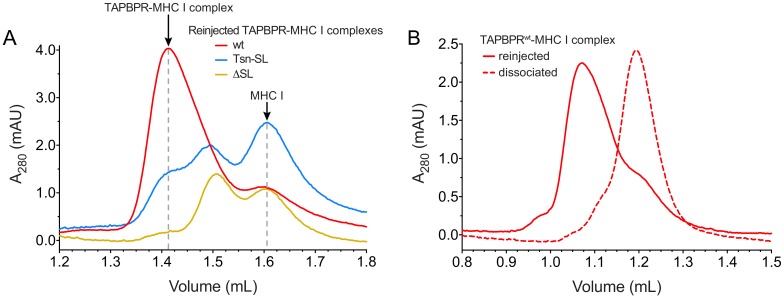
Stability of the MHC I complex formed by TAPBPRwt and the TAPBPR scoop-loop variants.(A) Re-analysis by SEC (Superdex 200) of SEC-purified peptide-free TAPBPRwt-H2-Db (red trace), TAPBPRTsn-SL-H2-Db (blue trace), and TAPBPRΔSL-H2-Db (yellow trace) complex. Please note that dissociated peptide-deficient H2-Db is unstable and gets lost during the course of the experiment. (B) SEC-purified peptide-free TAPBPRwt-H2-Db complex was re-analyzed by SEC (Superdex 75) without (solid red trace) and with prior incubation with a 100-fold molar excess of high-affinity peptide (ASNENMETM) (dashed red trace). Please note that the extinction coefficient at 280 nm of the MHC I including β2m is 2.6-fold higher than the extinction coefficient of TAPBPR.